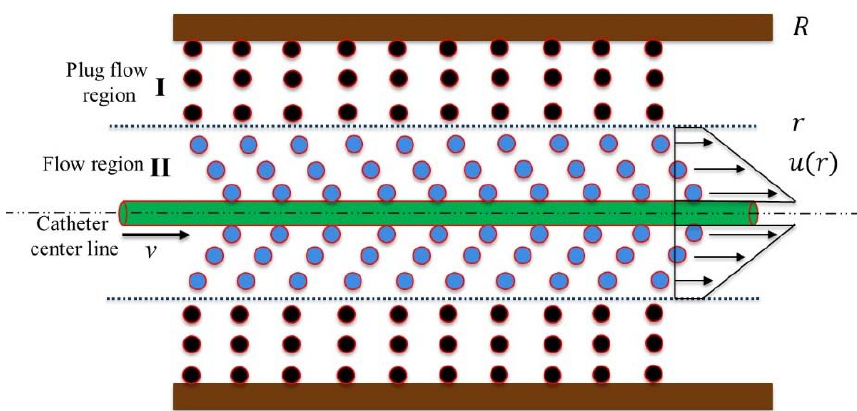
Figure 7. Stress diagram and velocity profile of the Bingham plastic shear flow in a cylinder container.